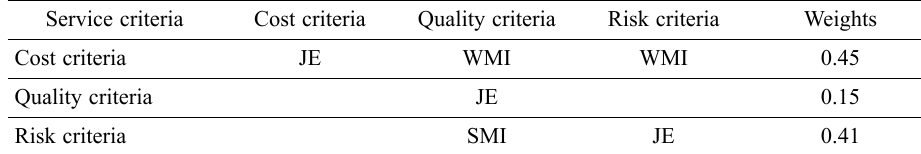
Table 10. Inner-dependency matrix of the criteria with respect to “service”